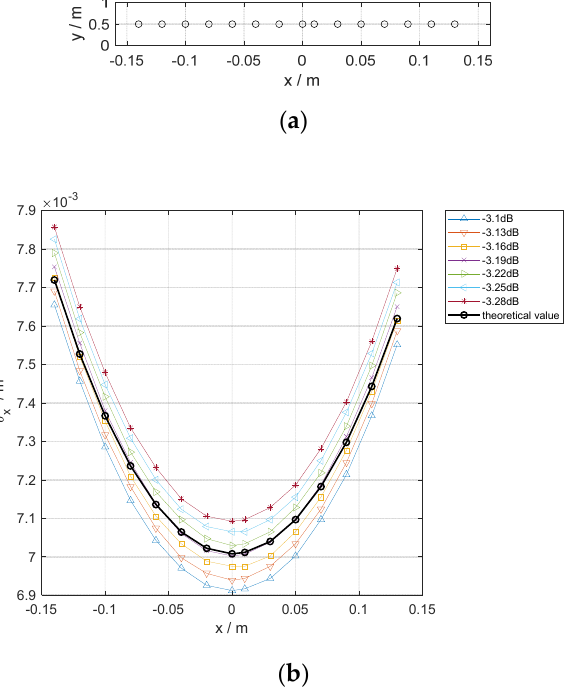
Figure 2. Cross ‐ range resolution simulation diagram; ( a ) Targets distribution; ( b ) Cross ‐ range Figure 2. Cross-range resolution simulation diagram; ( a ) Targets distribution; ( b ) Cross-range resolution resolution curve of different magnitude varying with the targets at x ‐ axis. curve of di ff erent magnitude varying with the targets at x